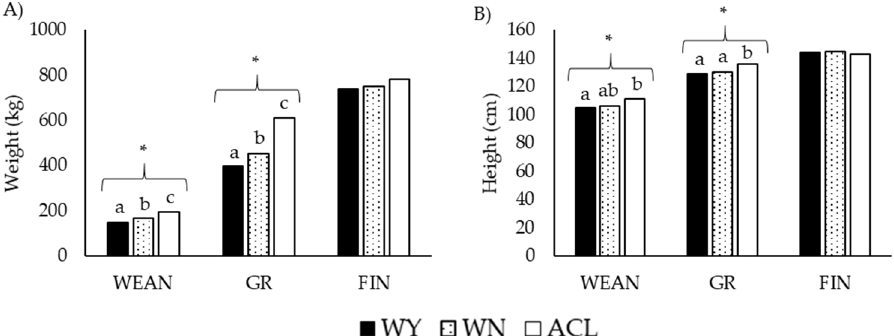
Figure 2. Transversal approach of ( A ) weight and ( B ) height of steers at three time points during fattening. Black bars: purebred Wagyu animals (WY); dotted bars: Wangus animals (Wagyu-by- Angus; WN); white bars: Angus-by-Charolais or Angus-by-Limousin crossbred animals (ACL). Abbreviations: WEAN: after weaning; GR: growing period; FIN: finishing period. Parameters are expressed as median values. Different superscripts a, b, and c indicate significant differences with * p < 0.001 by Kruskal–Wallis test.